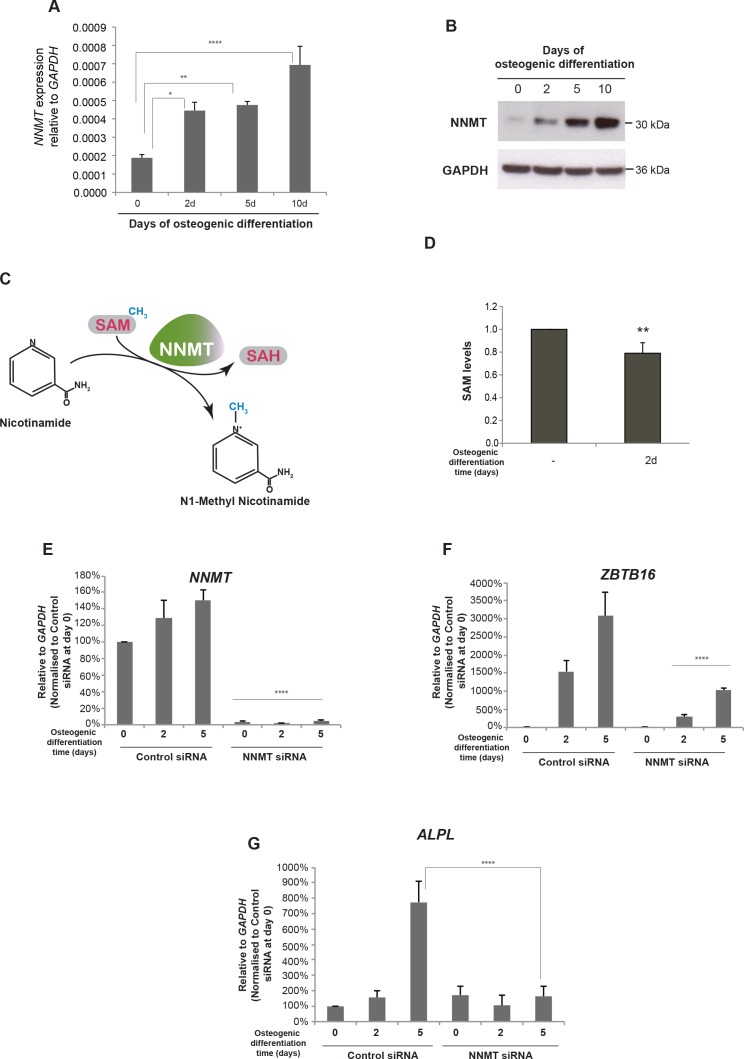
NNMT gene expression is induced during osteogenic differentiation and affects ZBTB16 and ALPL expression.(A–B) NNMT expression during osteogenic differentiation as analyzed by RT-QPCR and western blot. RT-QPCR data represents mean ± SD from three biological replicates. *p = 0.0223, **p = 0.0011, ****p < 0.0001, significance was calculated by two-way ANOVA using Bonferroni's multiple comparisons test. (C) Schematic presentation of the biochemical reaction whereby NNMT transfers a methyl group from SAM (S-adenosyl methionine) to nicotinamide, producing 1MNA (one methyl nicotinamide) and SAH (S-adenosyl homocysteine). (D) SAM levels measured by a fluorescence based assay (Mediomics) in hMSCs before and after osteogenic differentiation for 2 days. The data shown are averages of three biological replicates (p value = 0.01, two tailed t-test). (E) NNMT knockdown using siRNA in naive and osteogenic differentiated hMSCs, assessed by RT-QPCR. Two different siRNAs were used for knockdown of NNMT expression. Experiments shown are mean ± SD from three biological replicates. (F) Expression of ZBTB16 after NNMT knockdown analyzed by RT-QPCR. Experiments shown are mean ± SD from two biological replicates. (G) Expression of ALPL after NNMT knockdown analyzed by RT-QPCR. Experiments shown are mean ± SD from two biological replicates. ****p < 0.0001, statistical significance was calculated by two-way ANOVA using Tukey’s multiple comparisons test.Figure 6—source data 1.NNMT expression by RT-QPCR.Figure 6—source data 2.ALPL expression by RT-QPCR.Figure 6—source data 3.PLZF expression by RT-QPCR.